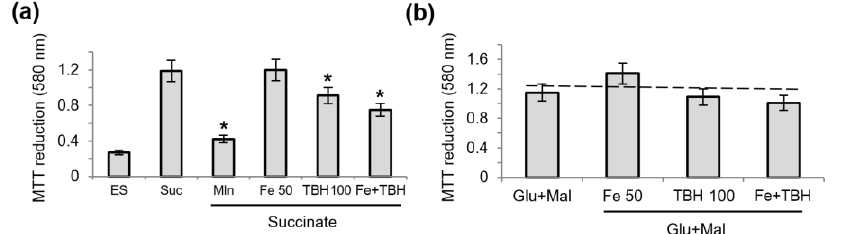
Figure 2. The influence of TBH and ferrous ions on the oxidation of succinate and NAD-dependent substrates. MTT reduction measured by an increase in optical density after the incubation of mi- tochondria without a substrate (ES) and in the presence of succinate (Suc), malonate (Mln), TBH, and ferrous ions ( a ); the influence of TBH and ferrous ions on MTT reduction during oxidation of glutamate with malate ( b ). Asterisk (*) indicates values that differ significantly from the control values ( p < 0.05).